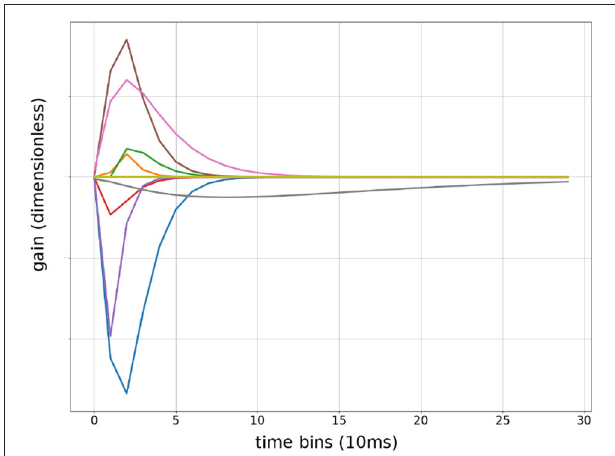
FIGURE 4 | Sample of convolutional Kernels: debug output of input weights to a randomly chosen first layer units from 9 input features. Time is in bins of 10 ms, up to 300